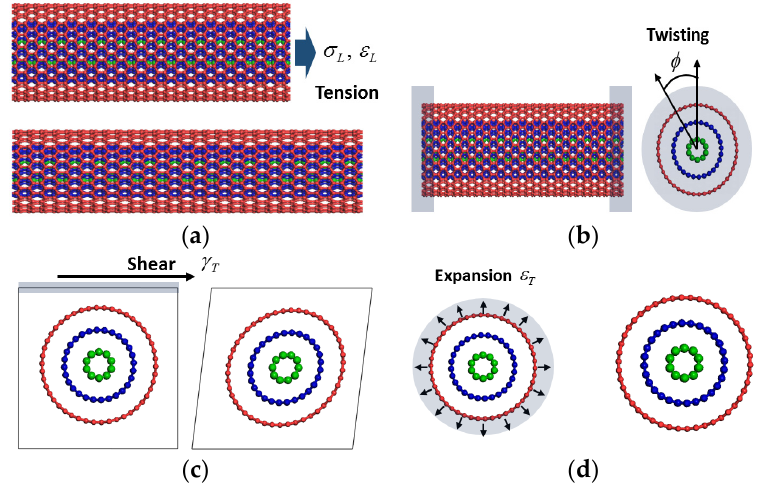
Figure 3. Molecular mechanics calculation scheme for transversely isotropic elastic constants of SWNTs and MWNTs. Schematics that illustrate the ( a ) longitudinal modulus and major Poisson’s ratio, ( b ) longitudinal shear modulus, ( c ) in-plane shear modulus, and ( d ) in-plane bulk modulus.